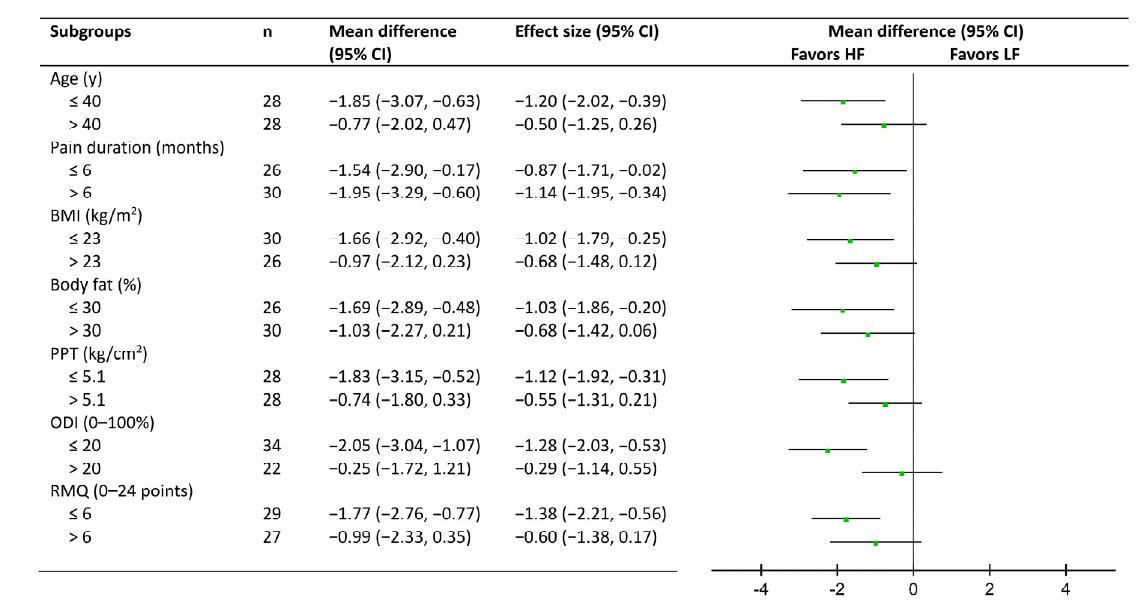
Figure 3. Subgroup Analysis of the Effect of Applied Force on Short-Term Pain